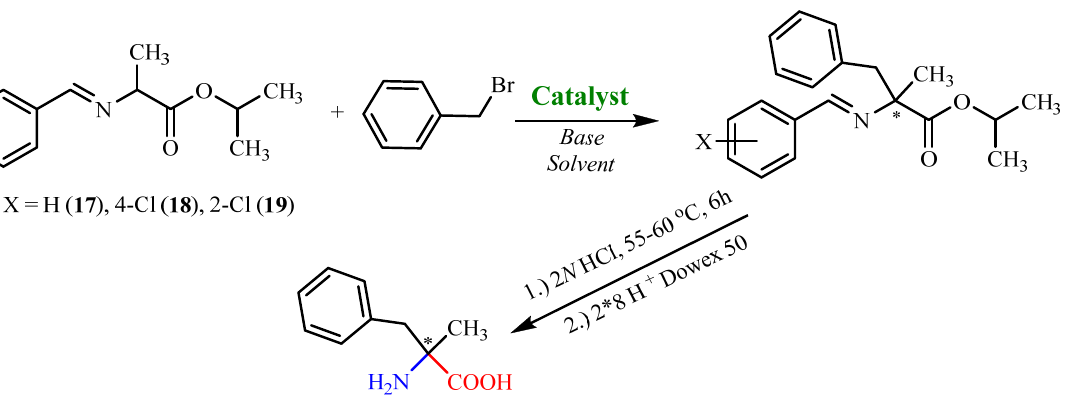
Scheme 2. C α -alkylation of the amino acid derivatives described in this work. Table 3. Experimental data for the C-alkylation of substrate 17 with benzyl bromide in the presence of complex 1.